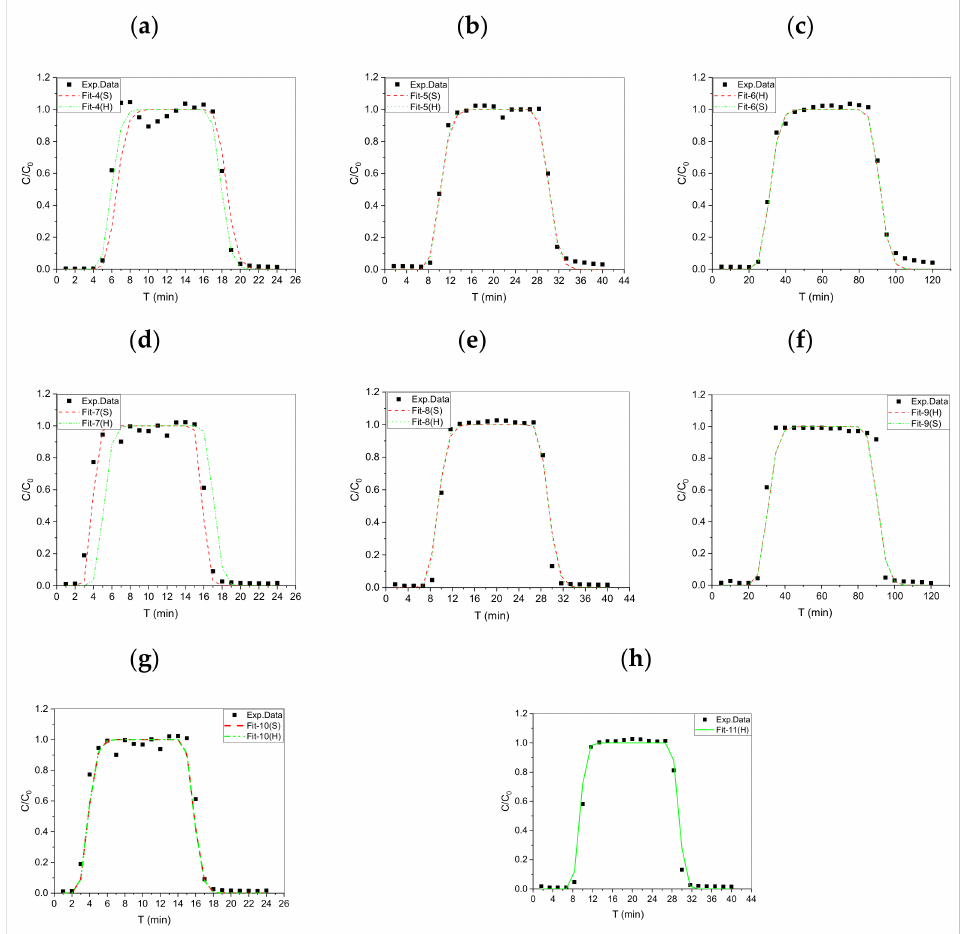
Figure 5. The experimental breakthroughs of I − and IO 3 − fitting curves. ( a ) IO 3 − : 5.0 ± 0.1